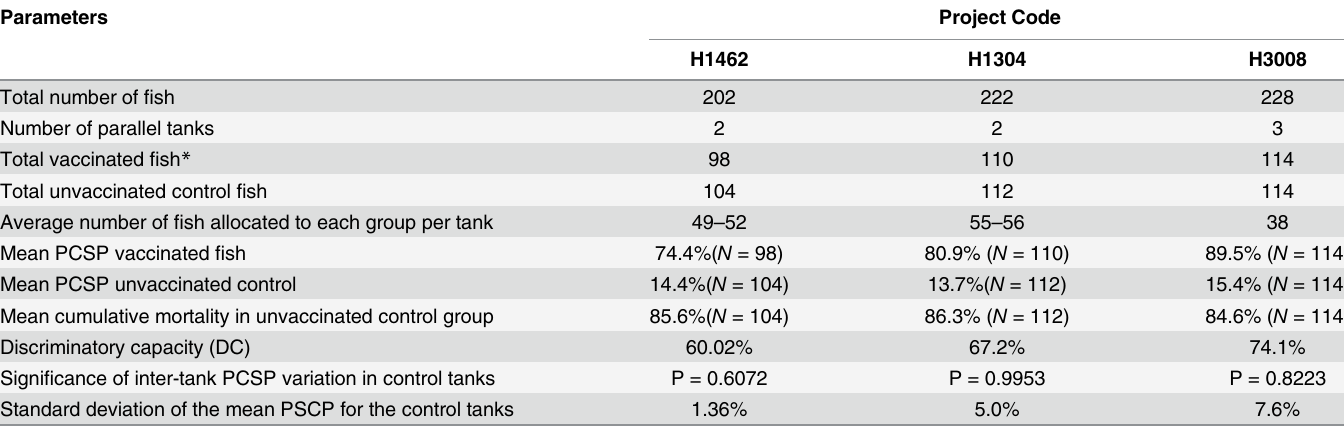
Table 4. Comparison of three independent vaccine efficacy trials using the cohabitation challenge model in Atlantic salmon